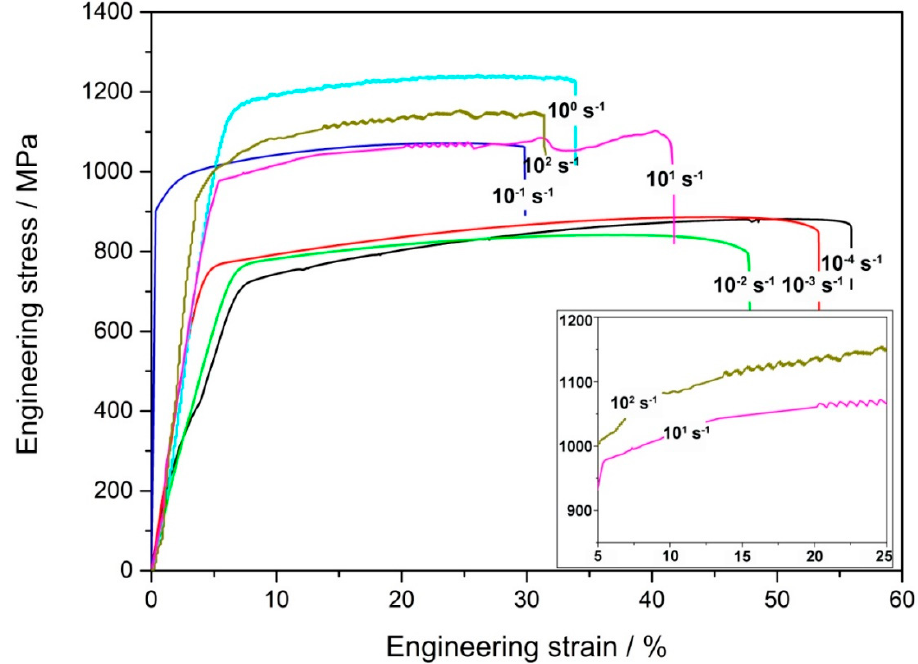
Figure 1. The engineering stress–strain curves of Fe–30Mn–9Al–1C steel tested at various strain rates. Pronounced serrations can be observed in the curves of steels tested at 10 1 s − 1 and 10 2 s − 1 strain rates in the inset.